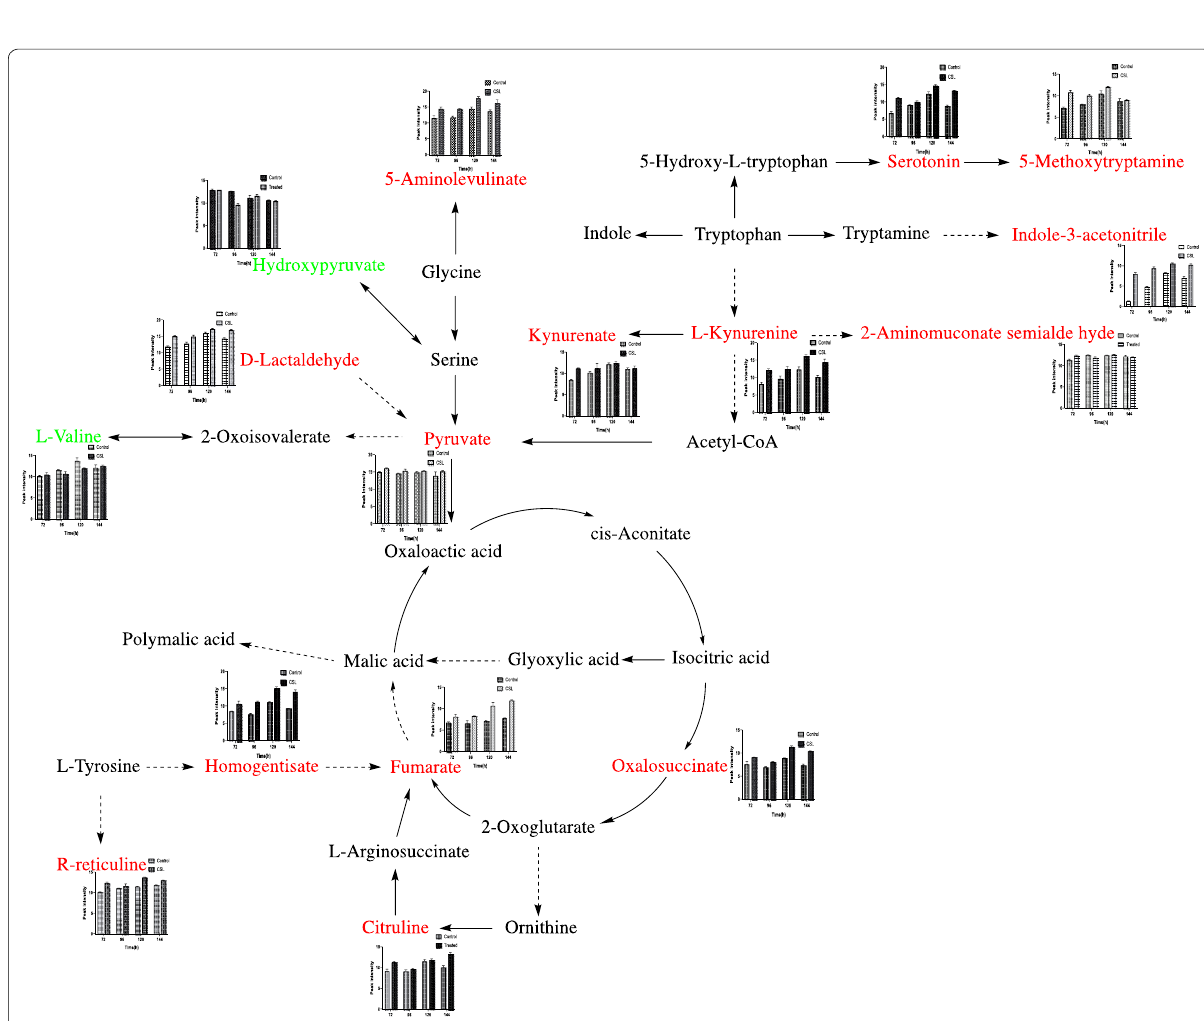
Fig. 5 Metabolic pathway related to the PMLA biosynthesis based on the metabolomics data (color in red and green represent up-regulated and down-regulated metabolites)